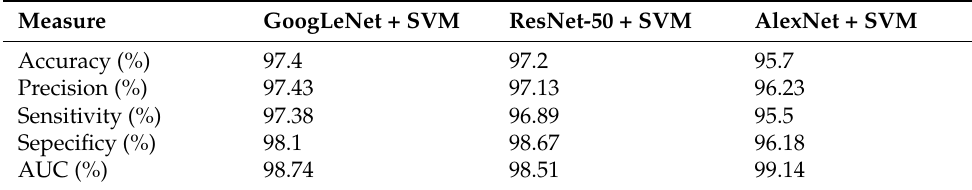
Table 5. Evaluative results of diagnosed CT Images of hemorrhage dataset using GoogLeNet + SVM, ResNet-50 + SVM and AlexNet + SVM.